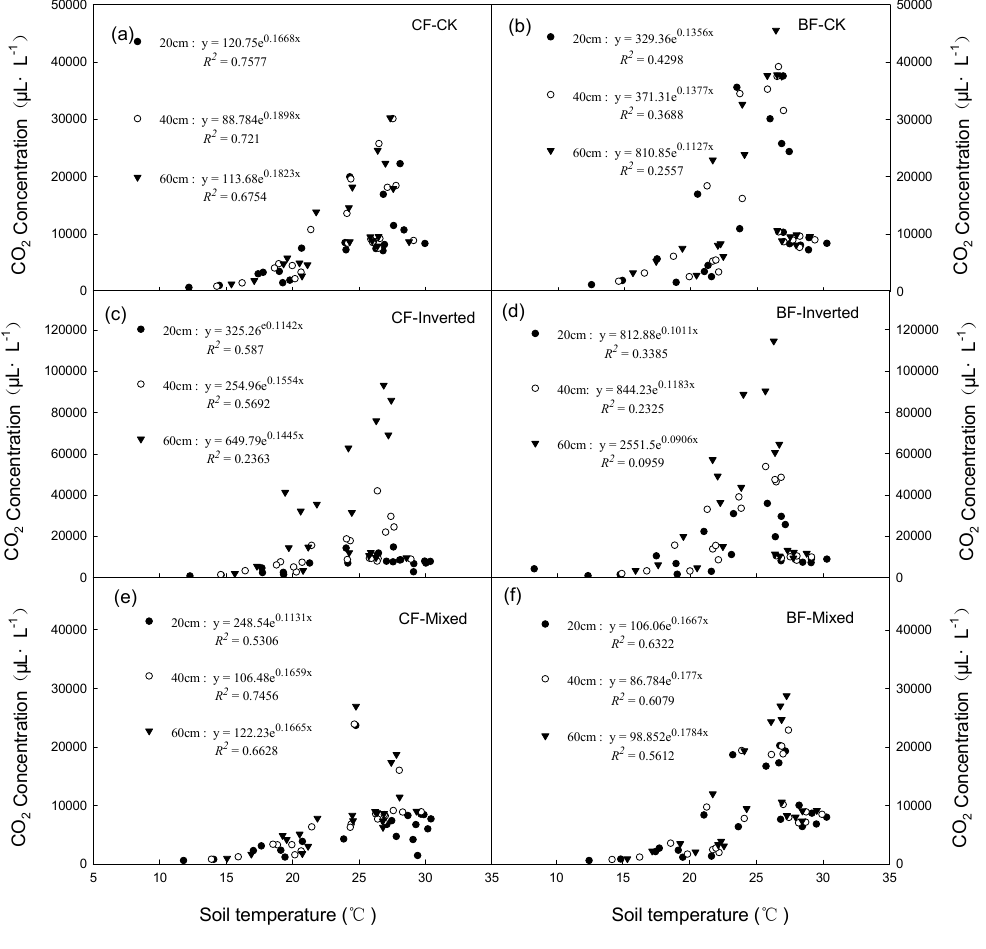
Figure 3. Relationship between soil profile CO 2 concentration and soil temperature. Different soil column treatments were: ( a ) CF-CK; ( b ) BF-CK; ( c ) CF-Inverted; ( d ) BF-Inverted; ( e ) CF-Mixed; and ( f ) BF-Mixed.